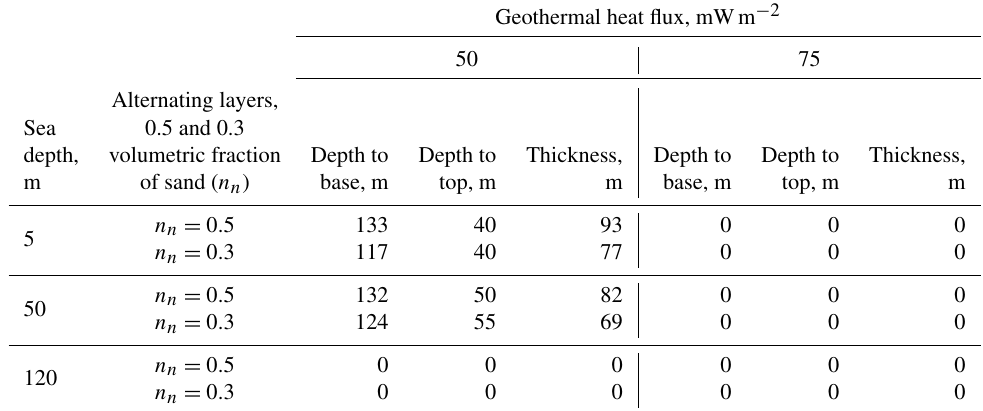
Table 3. Modeling results for depths to permafrost top and base and permafrost thickness for alternating sand and clayey silt (clay) layers, SW